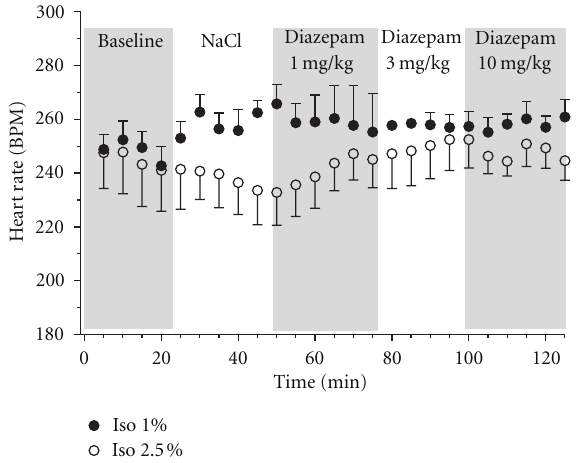
Figure 2: E ff ect of diazepam on heart rate in artificially ventilated (1% isoflurane, filled circles; 2.5% isoflurane, open circles; O 2 :N 2 O 1:1) female guinea pigs (538 ± 27g). The animals were placed on heated mats and the temperature was monitored and kept constant at 37 ± 1 ◦ C throughout the experiment. Electrocardiographic (ECG) recordings were obtained using 2 electrodes placed in the subcutaneous layer of the forelimbs (left and right), and 1 electrode placed in the subcutaneous layer of the left hind limb. ECG recordings were analysed using Chart ADinstrument software and Graphpad Prism 5. A stabilization period of minimum 20 min was performed, followed by NaCl 0.9% i.p. Subsequently the animals were injected intraperitoneally every 25th min with increasing concentrations of diazepam (1, 3 and 10mg/kg